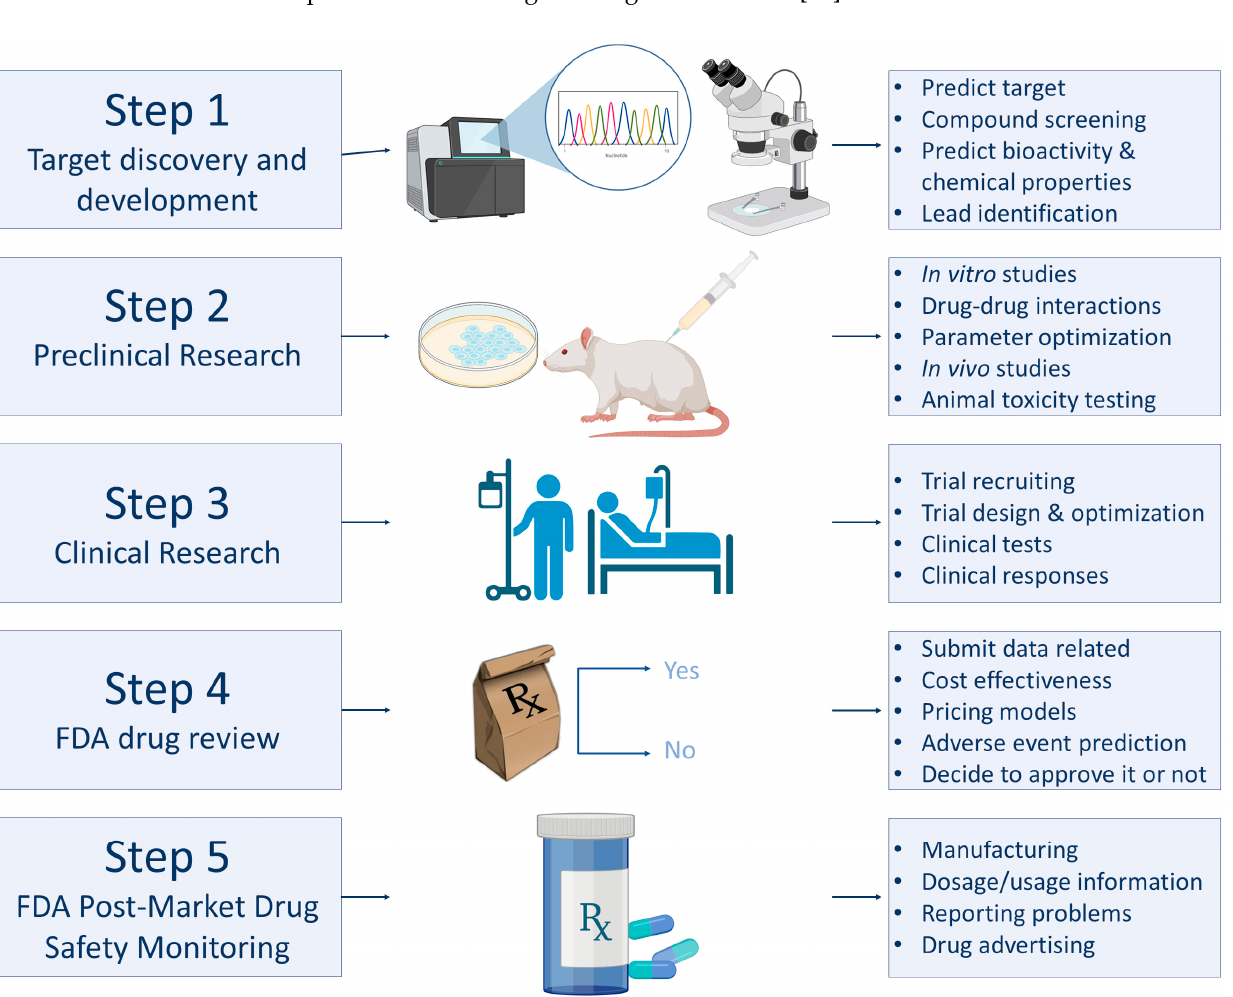
Figure 3. The 5 phases of drug design and development process. The phases are divided into the basic research and the early discovery phase (step 1), pre-clinical trials (step 2), the clinical development phase (step 3), the FDA review process (step 4), and finally the post-marketing surveillance phase (step 5).